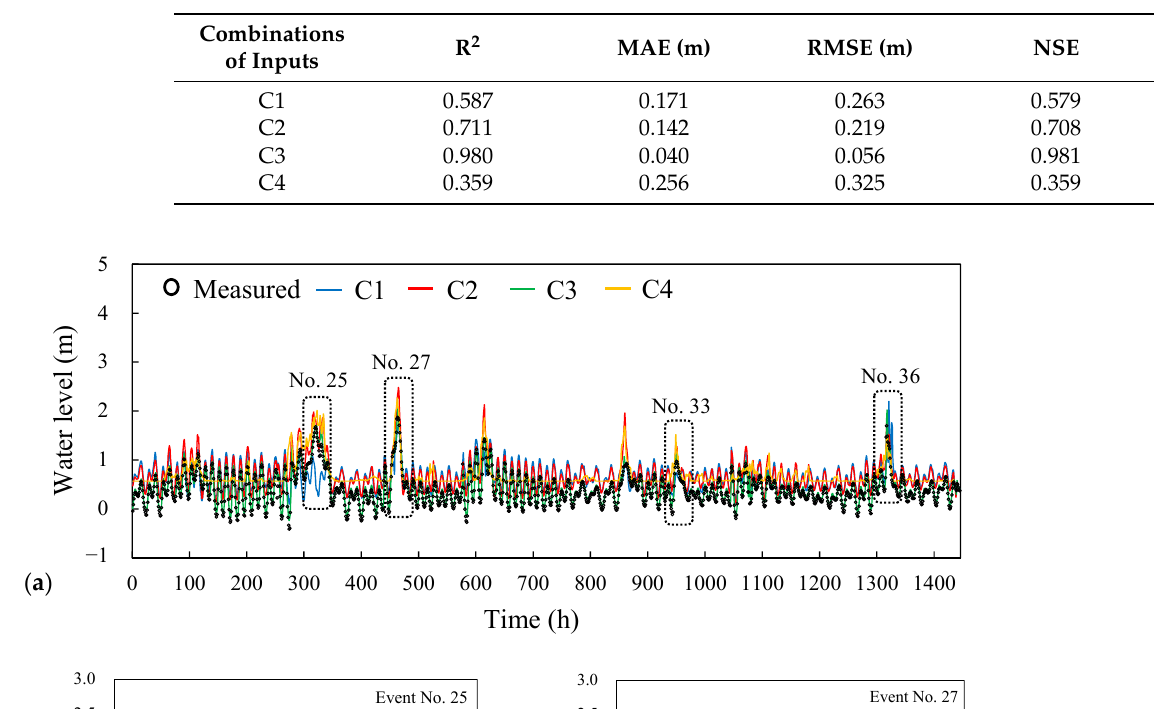
Table 4. Training performances of river stage forecasting using SVR with four input combinations.